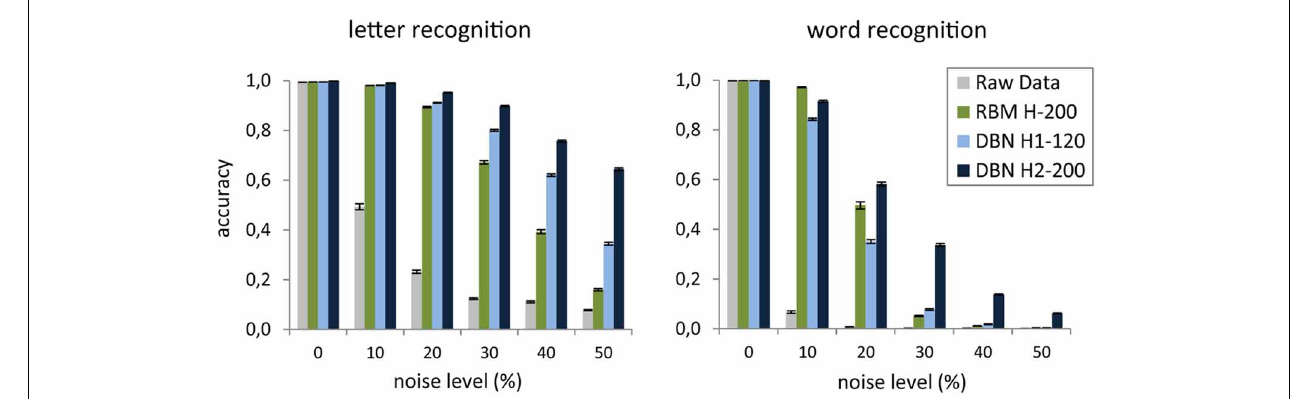
injections and it is computed over the entire dataset of words. Error bars represent SEM. The results are shown for read-out from the two hidden layers of a deep network (DBN), a shallow network (RBM), and raw